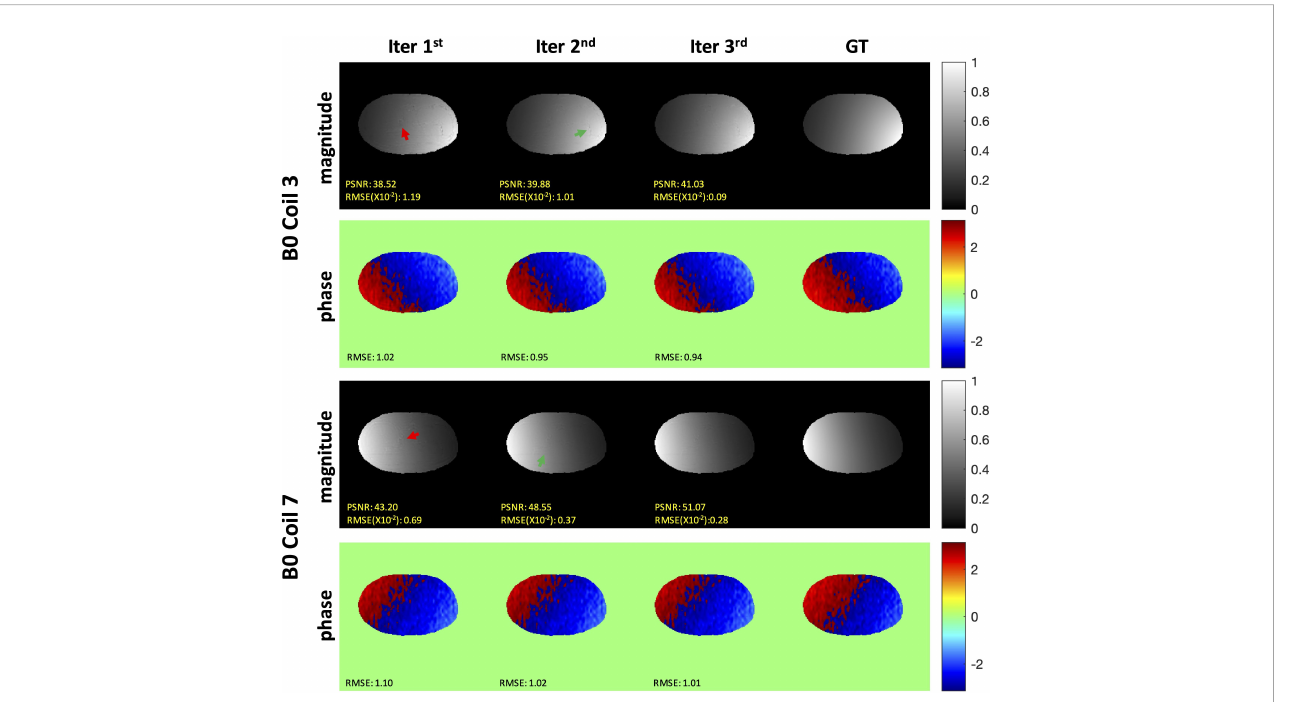
FIGURE 6 The representative iterative sensitivity map estimation of the two coil units. The 1st and 3rd rows show the magnitude images with the sensitivity pro fi les. The 2nd and 4th rows indicate phase images with sensitivity pro fi les.